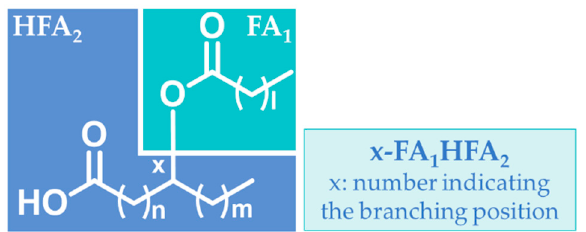
Figure 2. Structure of fatty acid esters of hydroxy fatty acids